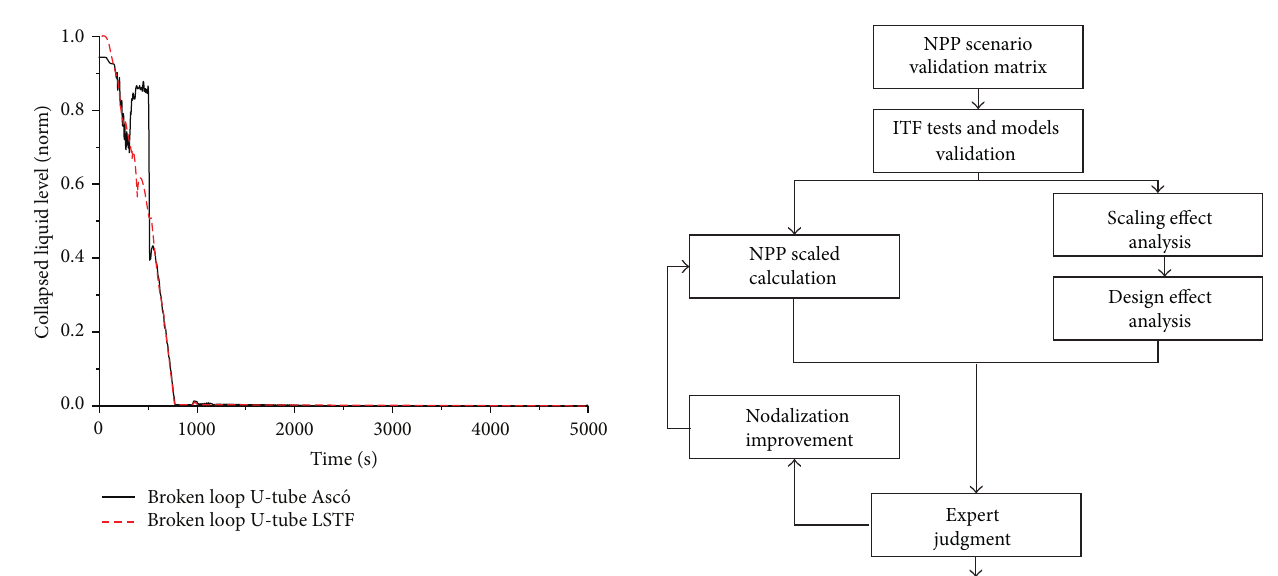
Figure 3: U-tube collapsed liquid level (picture from [23]).